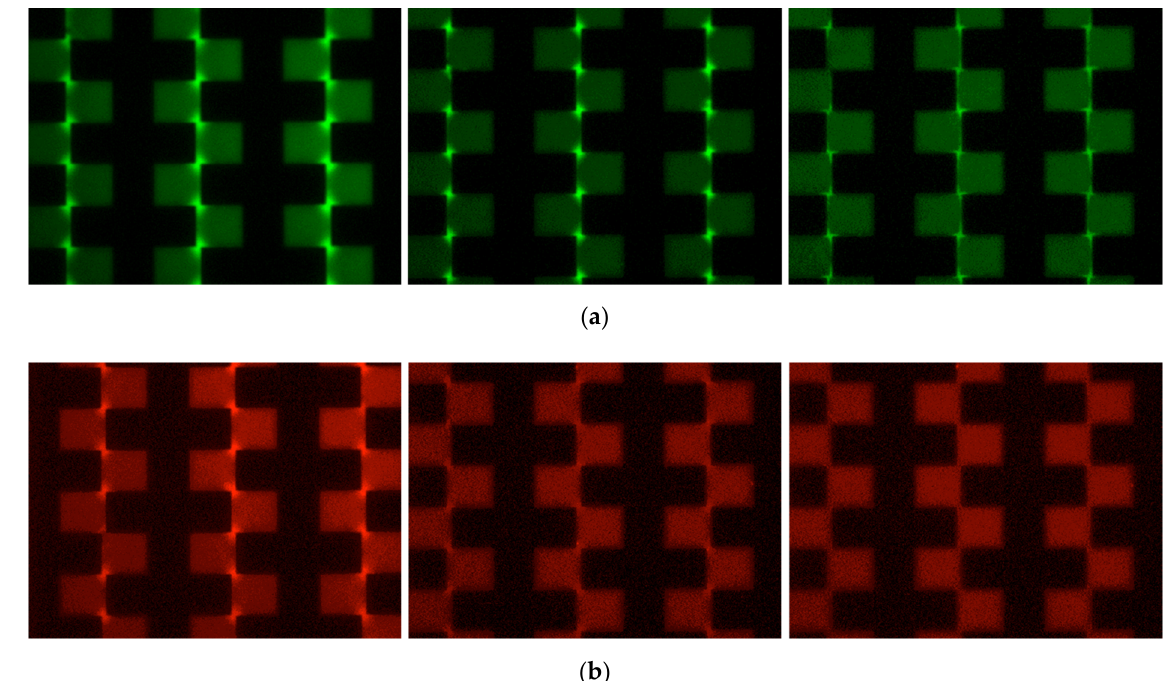
Figure 4. DEP separation of the exosomes. The human breast milk exosome ( a , green) and the human breast cancer exosome ( b , red) were mixed. The frequencies of the applied voltage were 1 MHz, 700 kHz, and 300 kHz (left to right). The photos are shown in pseudo-color images. The conductivity of the suspension medium was 40 µS/cm. The magnitude of the applied voltage was 20 V PP .